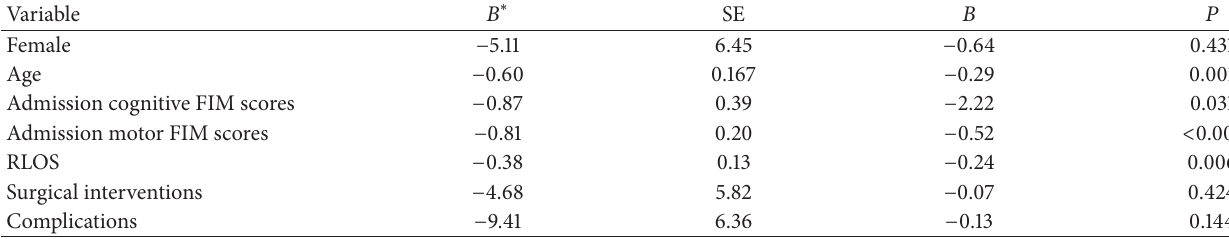
Table 6: Multiple linear regression analysis model on FIM Gain in TREATS